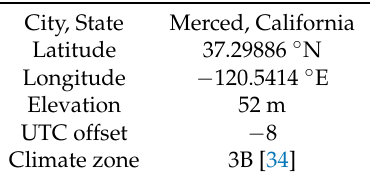
Table A1. Location information.